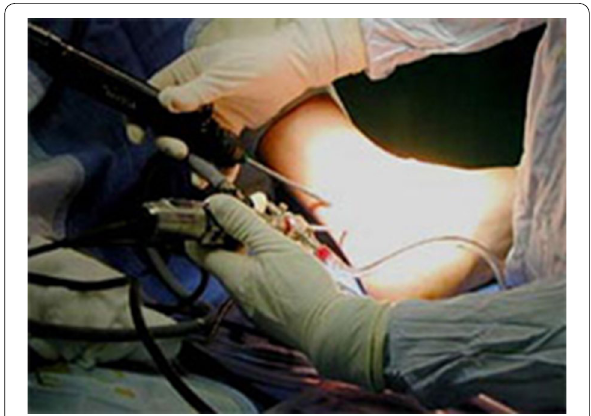
Fig. 2 Intra-operative image of portals during surgery